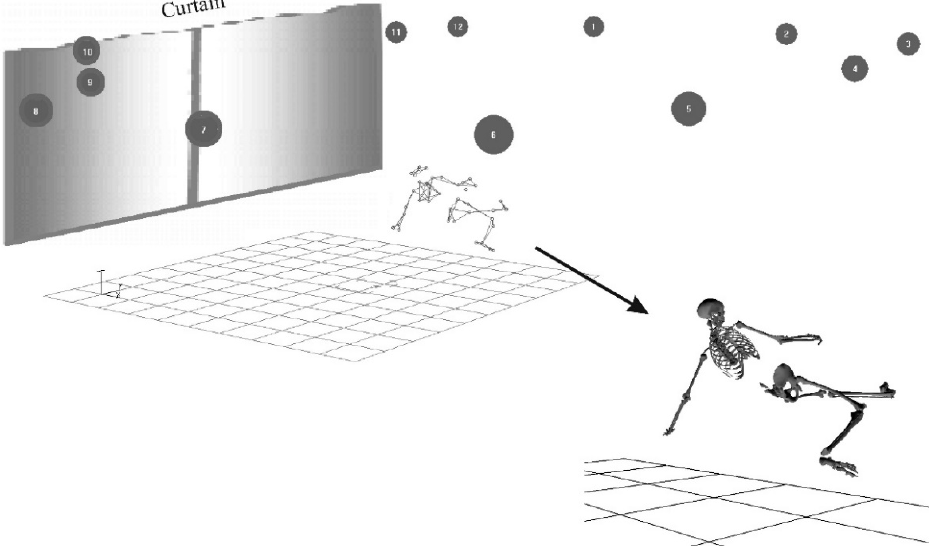
Figure 3. 3D motion capture reconstruction showing the 12 camera placements and a wire frame mesh reproduction of a jumping side volley (left) and a 15-segment biomechanical model built from the 3D data collected.